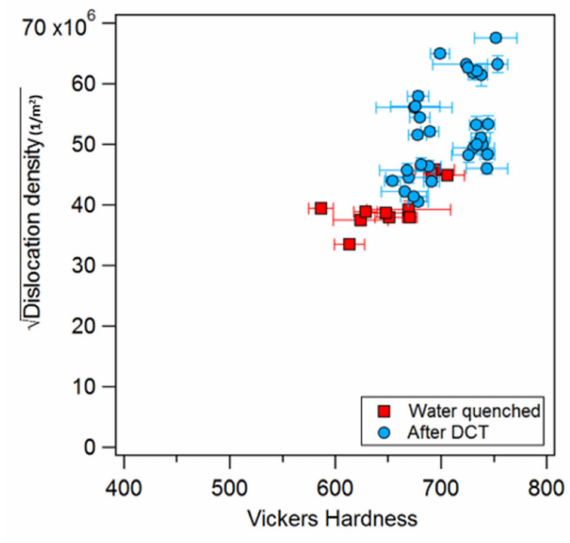
Figure 13. The correlation between hardness and the square root of the measured dislocation